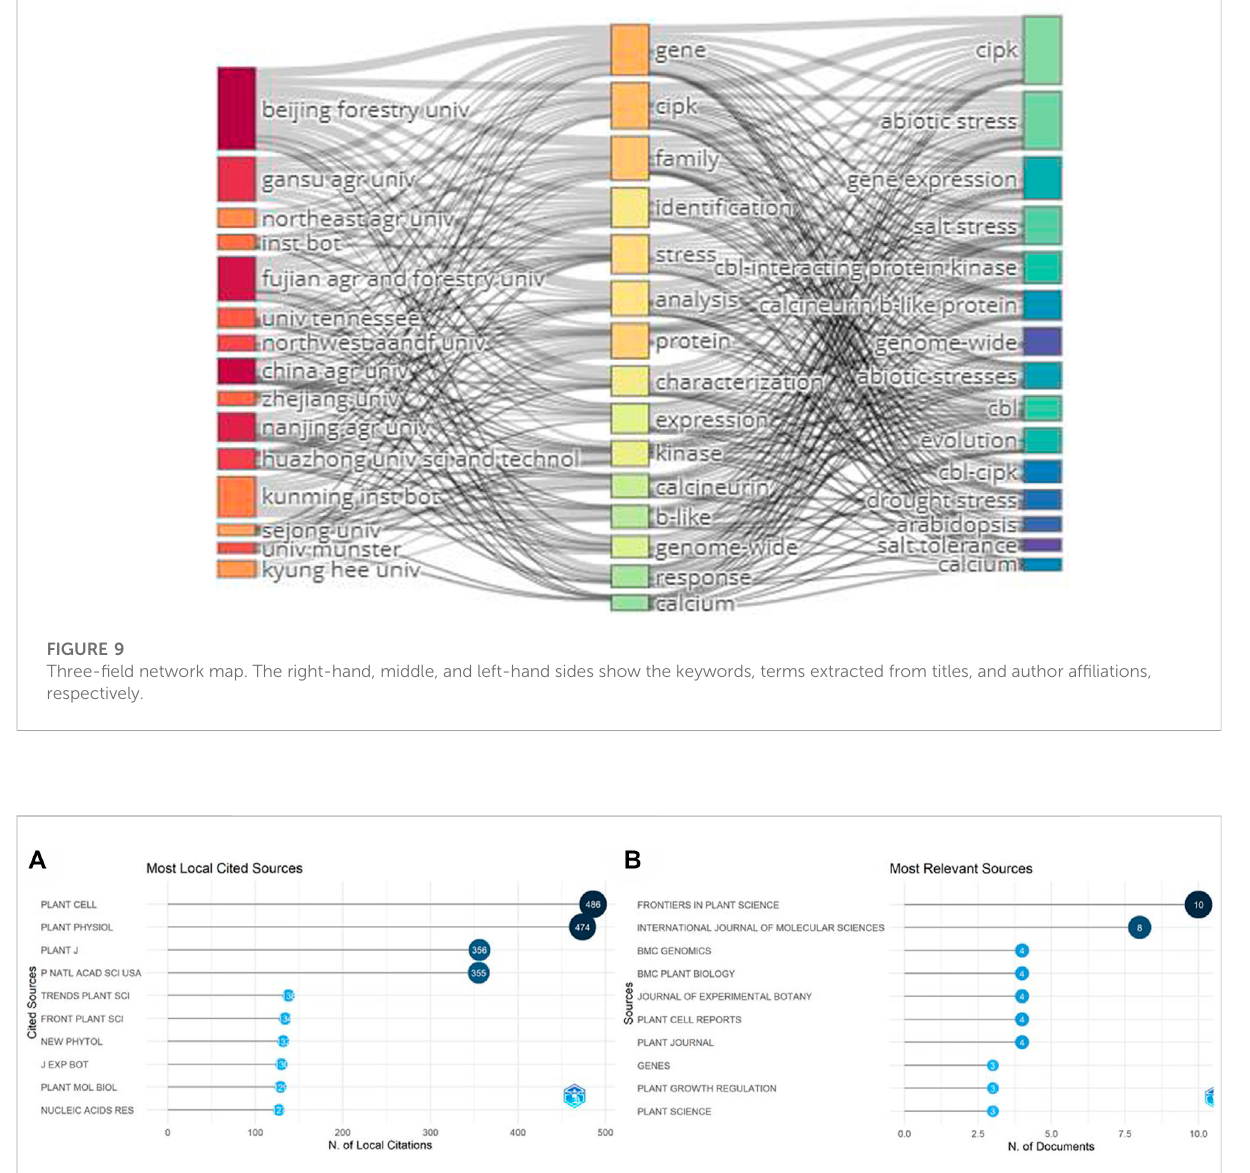
FIGURE 10 Most relevant sources. (A) The most locally cited sources. (B) The most relevant sources according to the number of